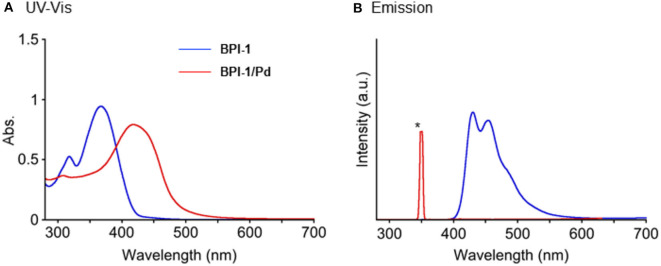
(A) UV-Vis absorption spectra and (B) fluorescence spectra upon excitation at 350 nm of BPI-1 and BPI-1/Pd complex in CH2Cl2 at 25°C. [BPI-1] = 2.28 × 10−5 M, [BPI-1/Pd complex] = 1.92 × 10−5 M. *Stray light.